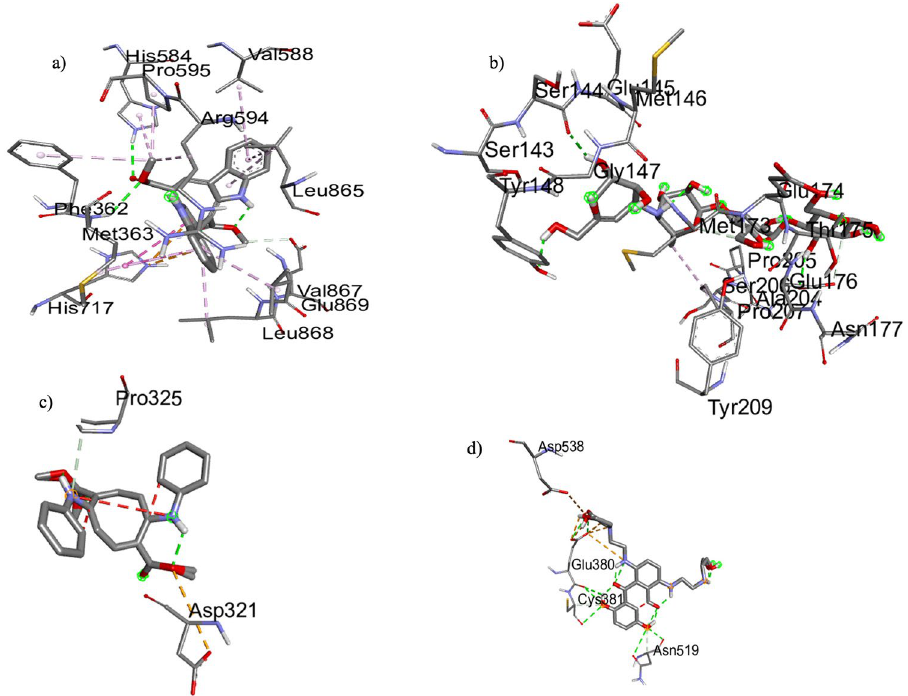
Figure 7. Binding posepre dictions for docked ligands (green) superposed on crystallographic structures for six representative targets. Key hydrogen bonds are shown by yellow lines, and the protein molecular surface is colored by atom type. Images generated with